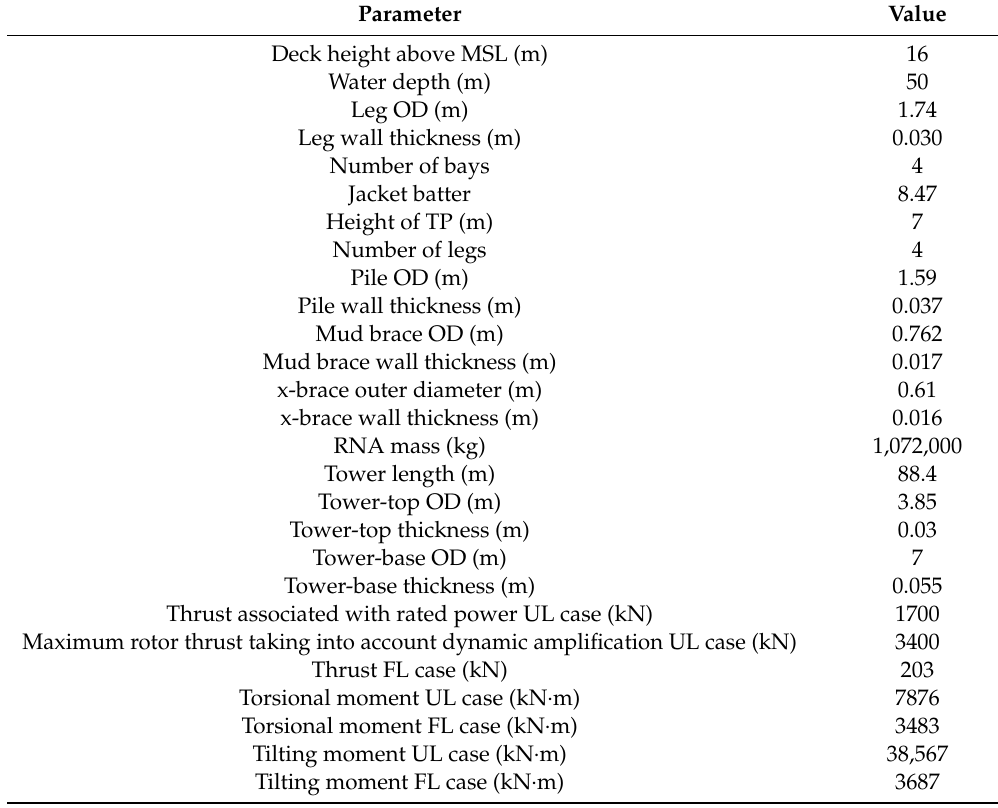
Table 3. Baseline 10-MW support structure parameters [5,8,80,83]. MSL—mean sea level;